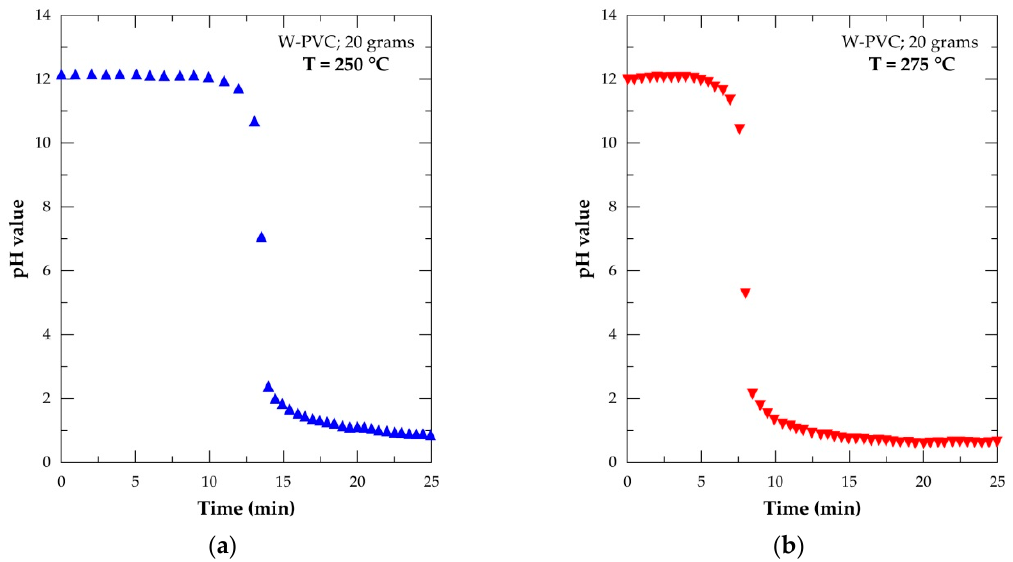
Figure 8. The pH value evolution versus the time of a solution scrubbing the outlet gas treatment of 20 g of W-PVC in the air atmosphere: ( a ) treated at 250 °C and ( b ) treated at 275 °C.